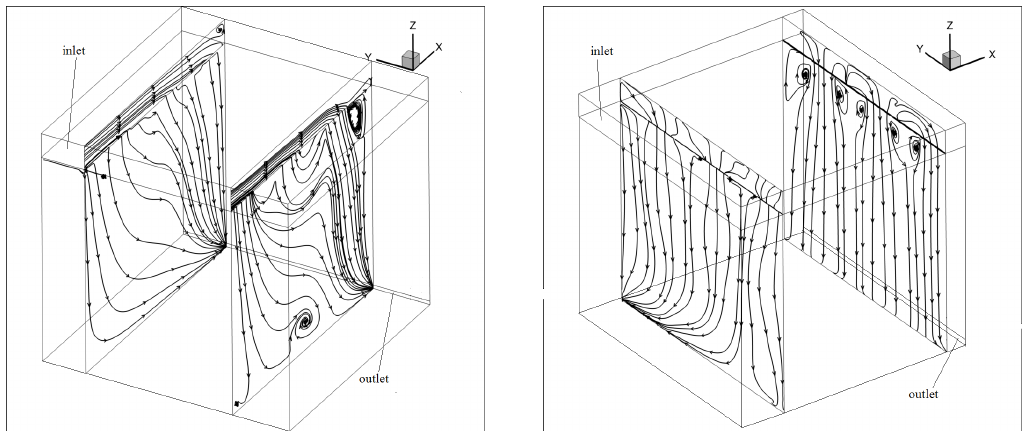
Figure 14. Streamlines for the chessboard distribution and the Outlet 2